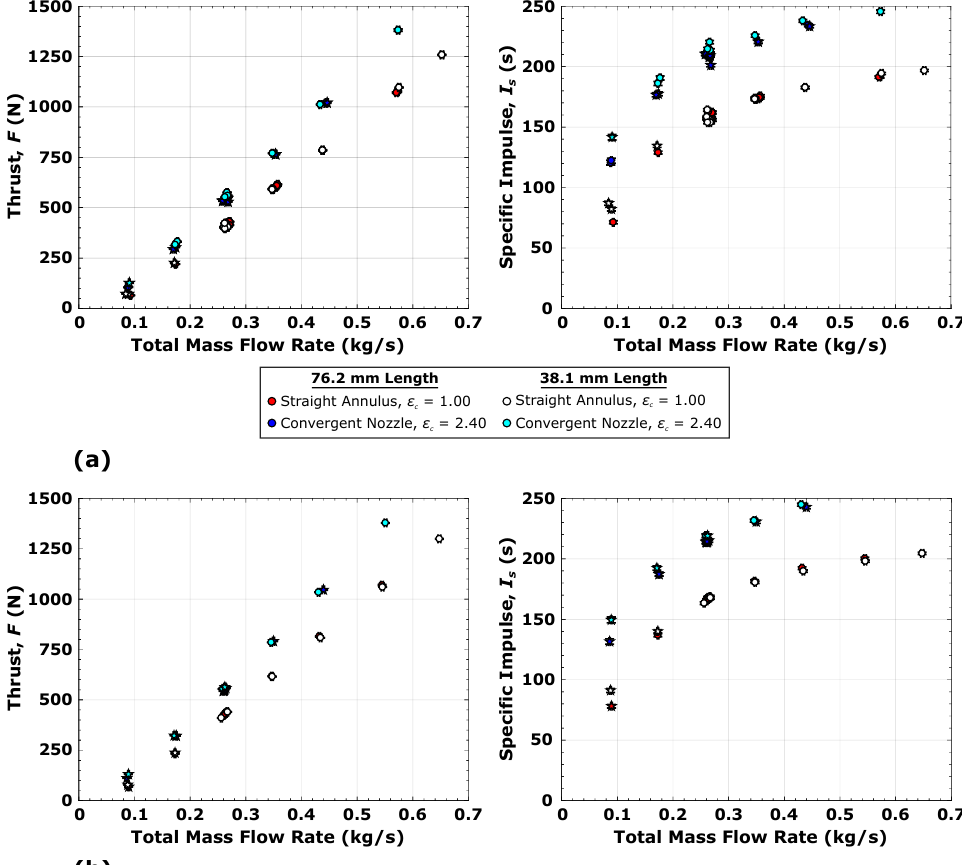
Figure 15. Performance summary for the shortened annular length study showing thrust F and specific impulse I s for the total mass flow conditions at φ equaling ( a ) 1.15 and ( b ) 1.5, respectively. Depending on the flow condition and convergent nozzle geometry, the engine operates in either a corotating ( • ) or counter-propagating mode ( (cid:63)